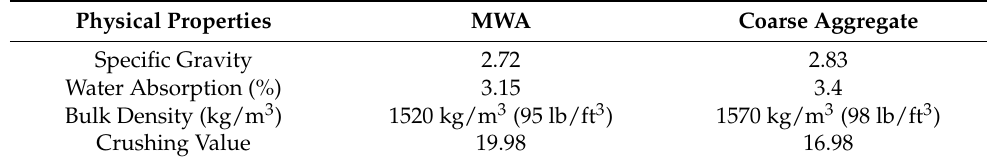
Table 3. Physical properties of MWA .